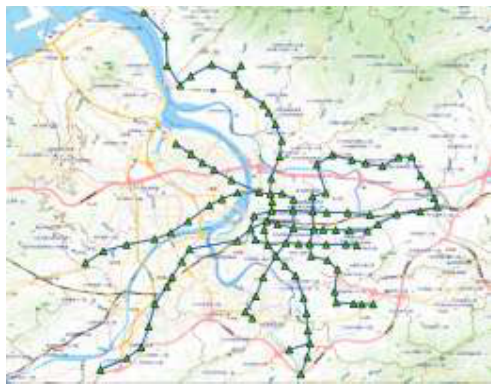
Figure 1 : MRT network (shape file with real world station location information, and green triangle is the MRT stations).